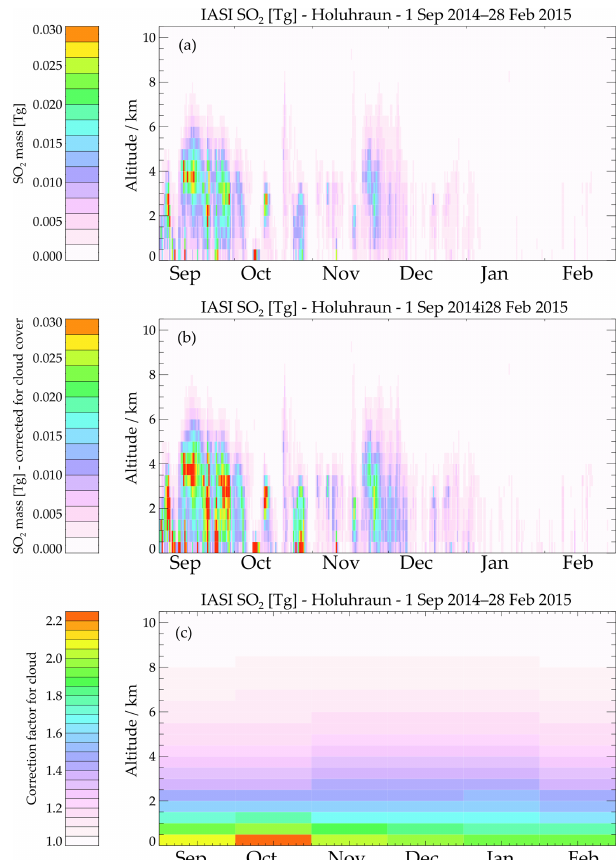
Figure 4. SO 2 vertical distribution in kilometres above sea level. The colours represent the mass of SO 2 , and dark red represents val- ues higher than the colour bar. Every column of the plot is gener- ated from an IASI map (one every 12h). Panel (a) shows the data obtained from the IASI maps. Panel (b) is (a) times the correction factor (to include SO 2 that statistically has been missed by the IASI measurements due to cloud above the plume). Panel (c) is the cor- rection factor C(h)